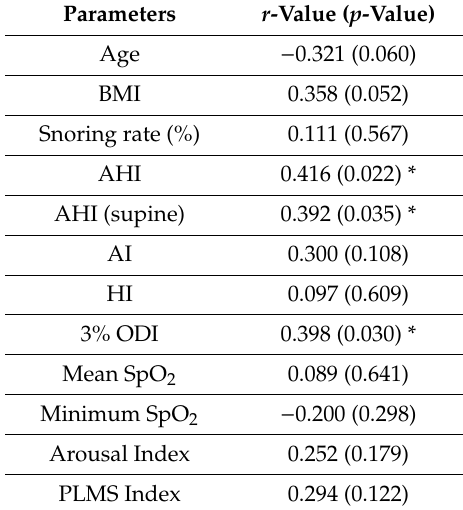
Table 3. Correlation matrix between various parameters and integrated R-R intervals (RRIs).